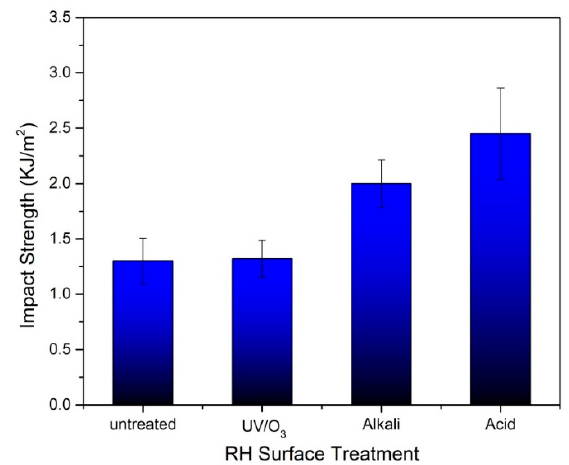
Figure 5. Impact strength of untreated, UV-, alkali- and acid-treated RH with 50 wt.% RH loading.